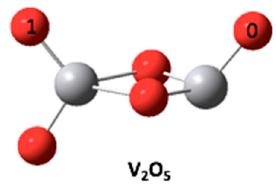
Figure 5. V 2 O 5 molecular model.